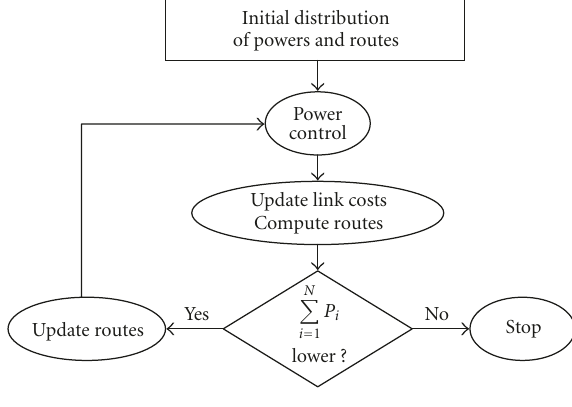
Figure 3: Joint power control and